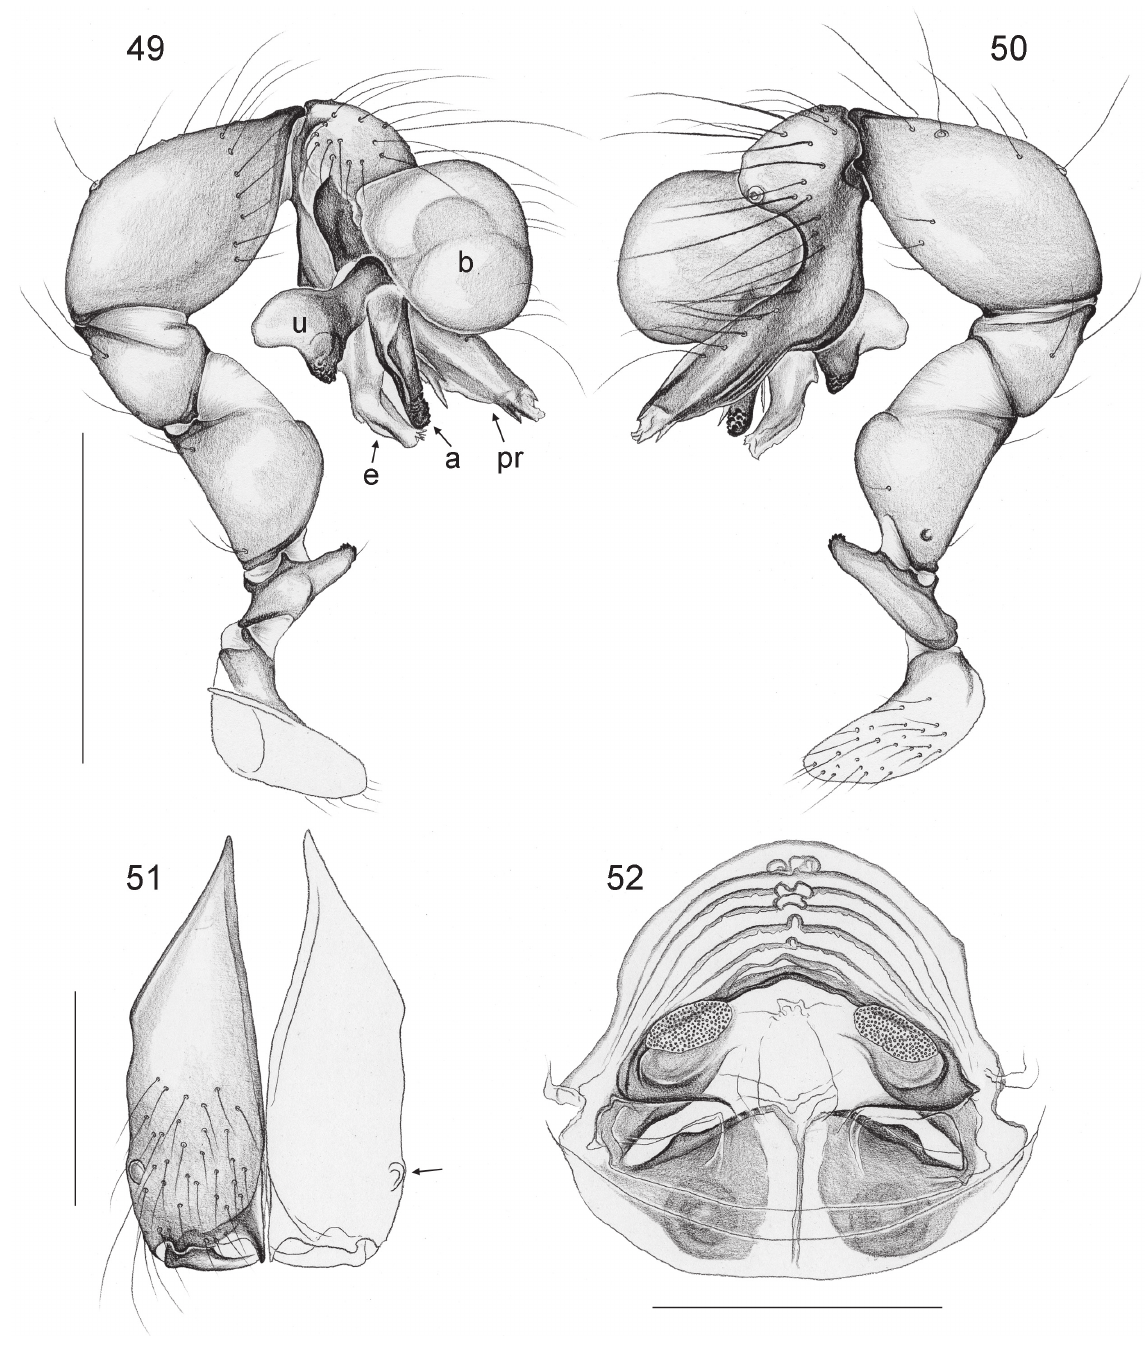
Figs 49-52. Leptopholcus gabonicus sp. nov. 49-50 . Left ♂ palp, prolateral and retrolateral views. 51 . ♂ chelicerae, frontal view (arrow points at lateral apophysis). 52 . Cleared ♀ genitalia, dorsal view. a = appendix; b = bulb; e = embolus; pr = procursus; u = uncus. Scale lines: 49-50, 52 = 0.3 mm; 51 = 0.2